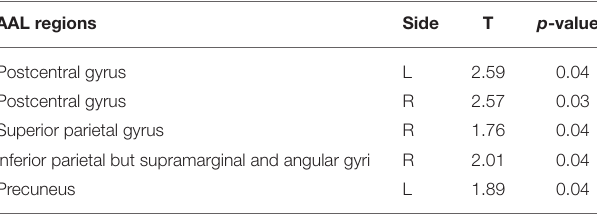
TABLE 2 | Differences in HE between genders in the AAL sub